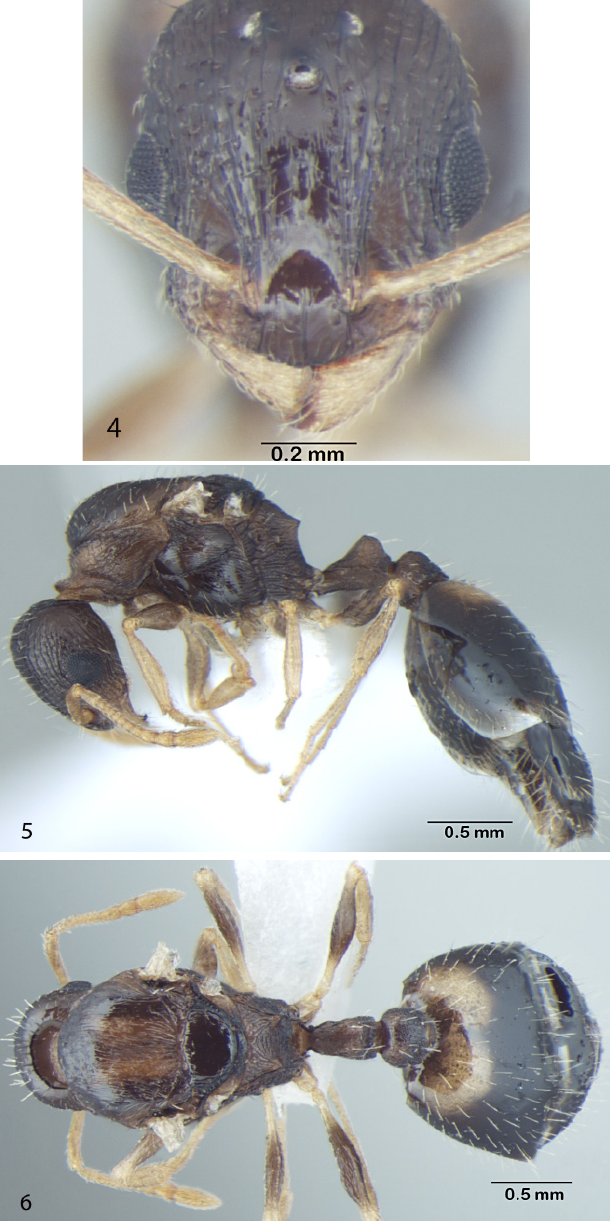
Figs 4-6 . Queen Temnothorax simlensis stat. nov.: 4- Head, full face view; 5- Body, lateral view; 6- Body, dorsal